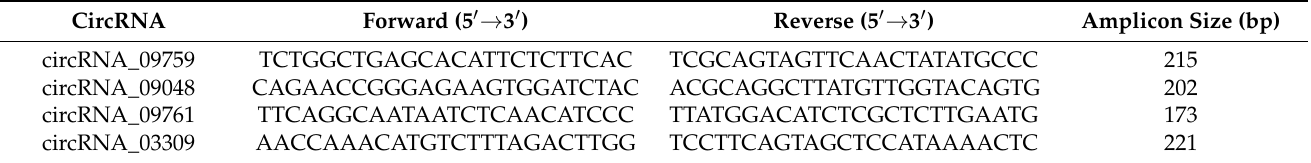
Table 1. PCR primers used to amplify specific